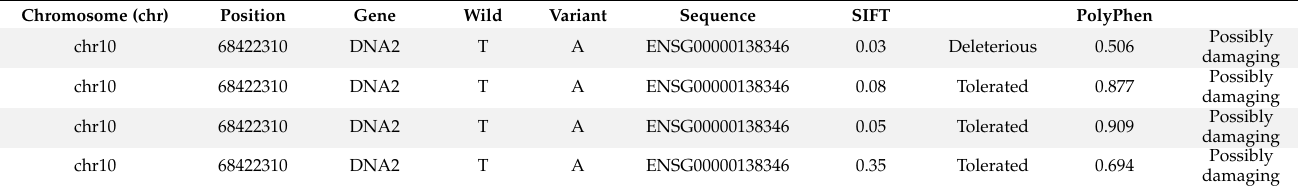
Table 4. Risk prediction of the new missense variants characterized in the